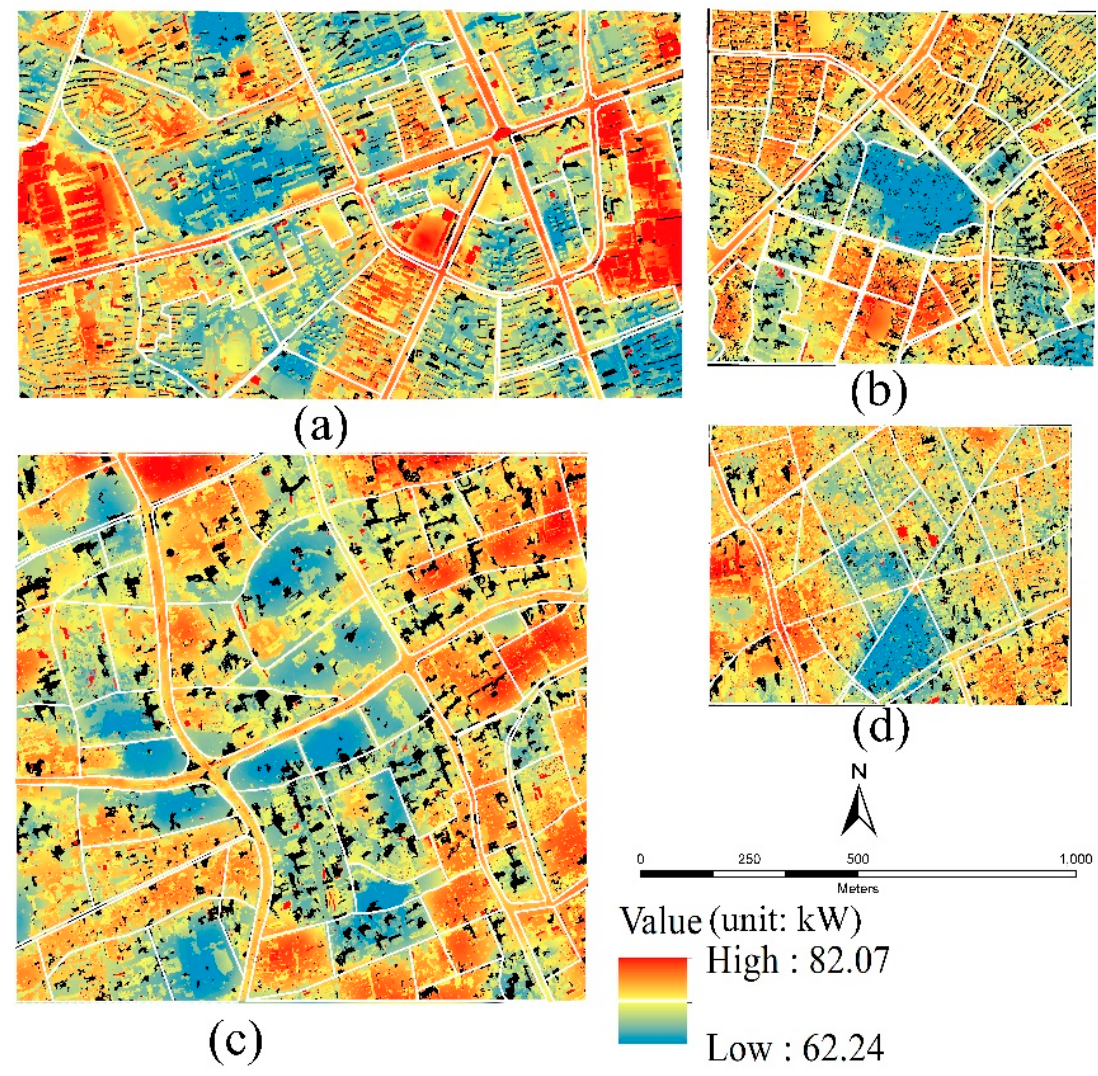
Figure 4. Parcel-level size-independent BBF (Mean_pc_BBF) at four UFZs. Note: The labels ( a ), ( b ), ( c ), and ( d ) denote the four UFZs known as Wujiaochang, PeacePark, UrbanCore, and Xujiahui, respectively. The definitions of white polygons and the black spots are the same as Figure 3.